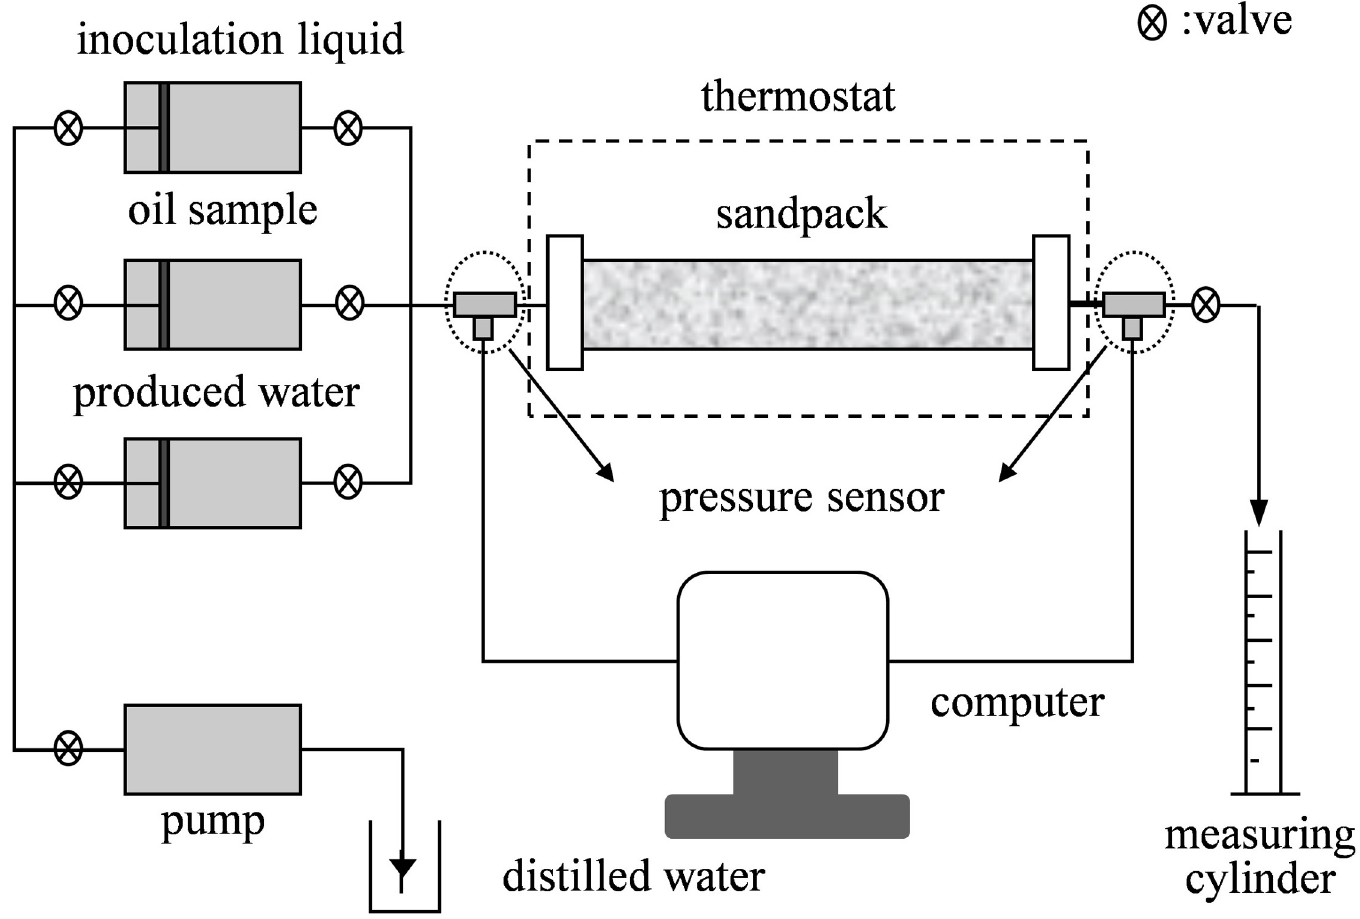
Fig 2. Core flooding experiment